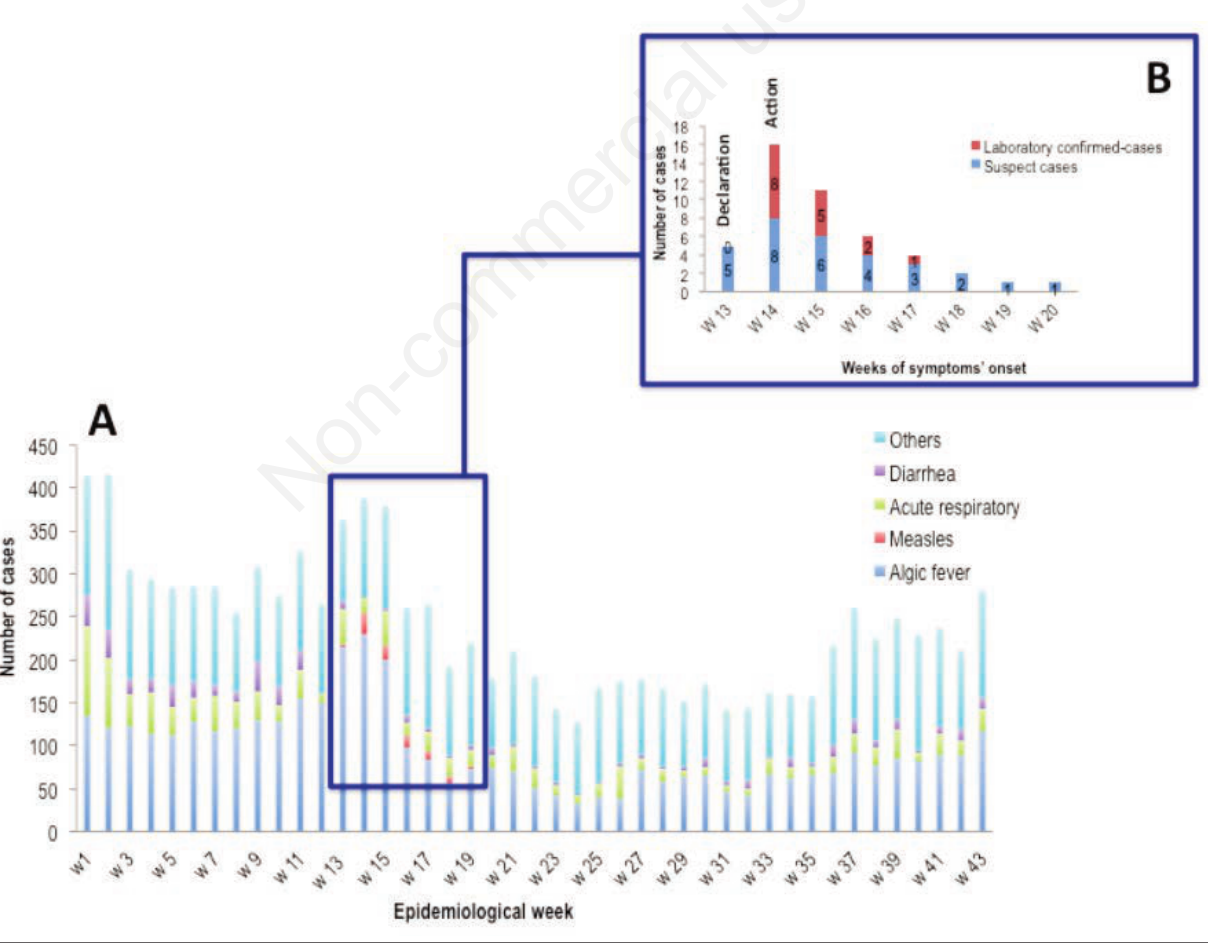
Figure 3. Distribution of measles cases by age, group and sex, Libreville-Oyem, March- May